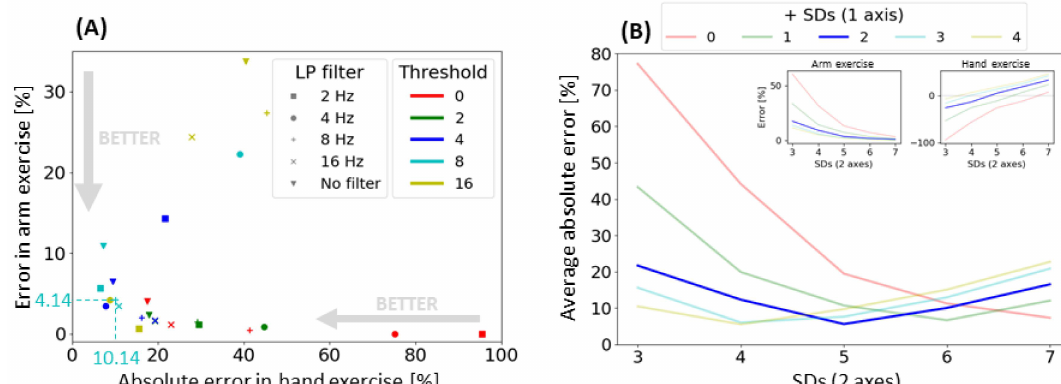
Figure 4. HAND algorithm parameter exploration. ( A ) Counting error for the arm-only exercise and the hand-only exercise for different thresholds (represented by the colors) and cutoffs (represented by the markers) for the low-pass filter. For the arm-only exercise, the error is calculated as the percentage of hand counts to the number of arm-only movements averaged across subjects. For the hand-only exercise, the error is calculated as the absolute difference between the number of hand counts as a percentage to the number of actual hand movements performed averaged across subjects. For both exercises, smaller errors are preferred. The errors for the selected parameters (LP filter cut-off = 8 Hz, threshold = 8) are highlighted. ( B ) Average error for arm-only and hand-only exercise of the hand count algorithm for different SD parameter 2 axes ( x -axis) and number of extra SD for 1 axis (represented by the color) using LP filter cut-off = 8 Hz, threshold = 8. The two inner figures show the percentage error for arm (left) and hand (right) exercises. The selected SDs are 5 for two axes plus 2 SDs for one